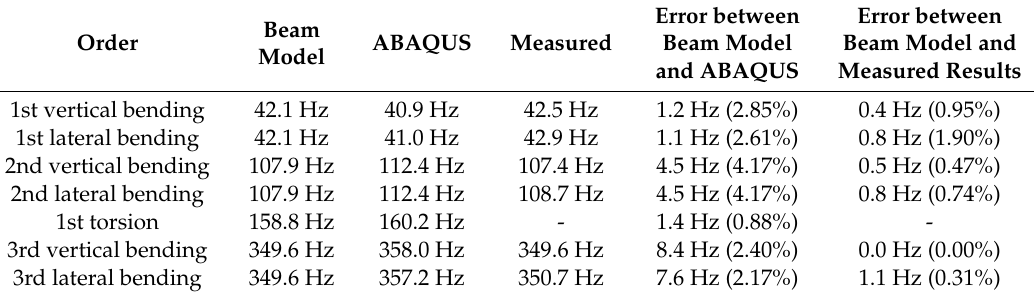
Table 2. Comparison of the natural frequencies from numerical calculation and experiment.